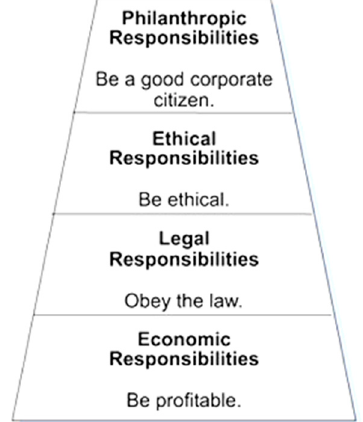
Figure 2. The Pyramid of Corporate Social Responsibility (CSR) model (Carroll 1991).